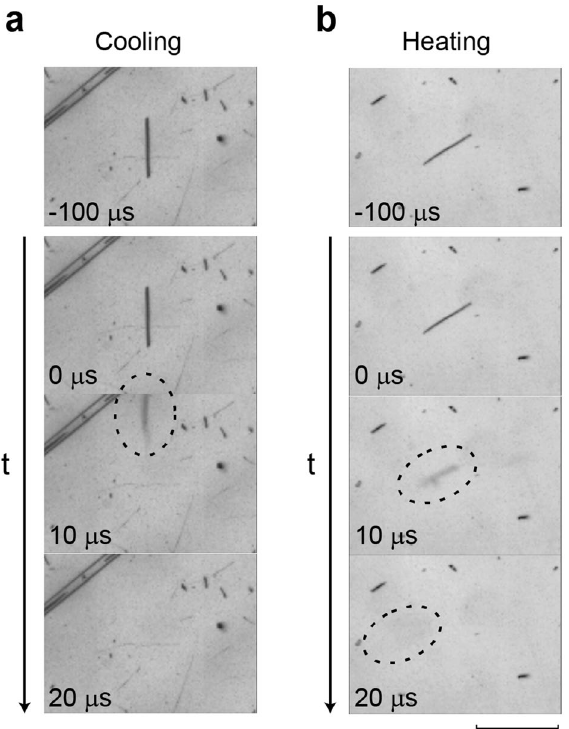
Figure 2. Jumping nanofibers recorded with high-speed camera operated at 10 5 fps. (a) Snapshots recorded during cooling. ( b) Snapshots recorded during heating. The topmost images were recorded 100 µs before jumping, showing that the jumps occurred without preliminary deformation. Scale bar: 100